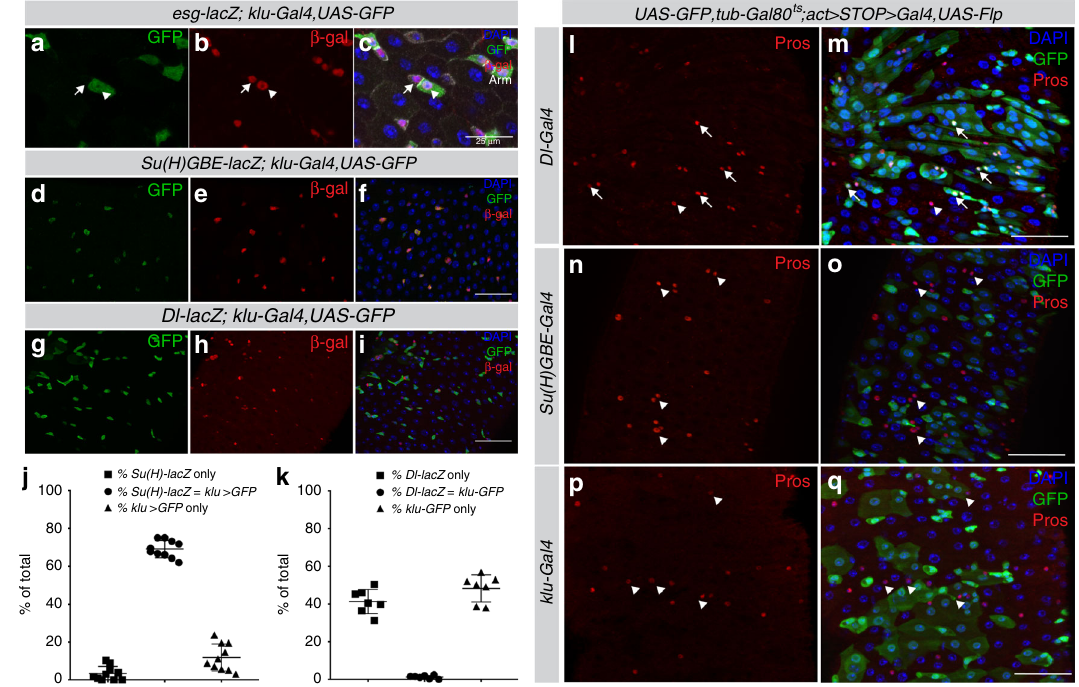
Fig. 1 Klu is speci fi cally expressed in enteroblast cells. a – c The klu-Gal4, UAS-GFP reporter line shows expression in the midgut epithelium. ISCs (arrows) and EBs (arrowheads) are visualized by esg-lacZ ( beta-galactosidase , red). Cells are outlined with Armadillo/beta-catenin (Arm, grayscale). Representative area of posterior midgut is shown. n = 3 animals. d – i The klu-Gal4, UAS-GFP was combined with Su(H)-GBE-lacZ (enteroblast (EB) marker) or Dl-lacZ (intestinal stem cell (ISC) marker). Expression of Klu largely overlaps with the EB marker Su(H)-GBE-lacZ ( d – f ), and Klu-positive cells are found adjacent to the Delta-positive ISCs ( g – i ). j Quanti fi cation of EB-marker gene overlap of the genotypes displayed in d – f . n = 10 guts/animals ( Su(H)-GBE-lacZ, n = 572 cells counted). k Quanti fi cation of ISC-marker gene overlap of the genotypes displayed in g – i . n = 7 guts/animals ( Dl-lacZ, n = 1370 cells counted). l – q Lineage-tracing of cells in the intestine using different cell-speci fi c drivers. EEs are marked by antibody staining for the transcription factor Prospero (Pros, red). Arrows indicate GFP-Pros double-positive EEs in the clonal area, whereas arrowheads indicate EEs outside the clonal area. l , m The Dl-Gal4 -positive ISCs give rise to both differentiated cell types of the intestinal lineage (enterocytes (EC) and enteroendocrine (EE) cells). n , o Su(H)-GBE -positive EB cells exclusively give rise to ECs, but not to EEs. p , q Similar to Su(H)-GBE -positive EBs, klu-Gal4 -positive cells give rise exclusively to ECs. Representative areas of posterior midgut are shown. n = 7 guts examined for l , m , n = 7 guts examined for n , o and n = 10 guts examined for p , q . Scale bar = 50 µ m, except in a – c : scale bar is 25 µ